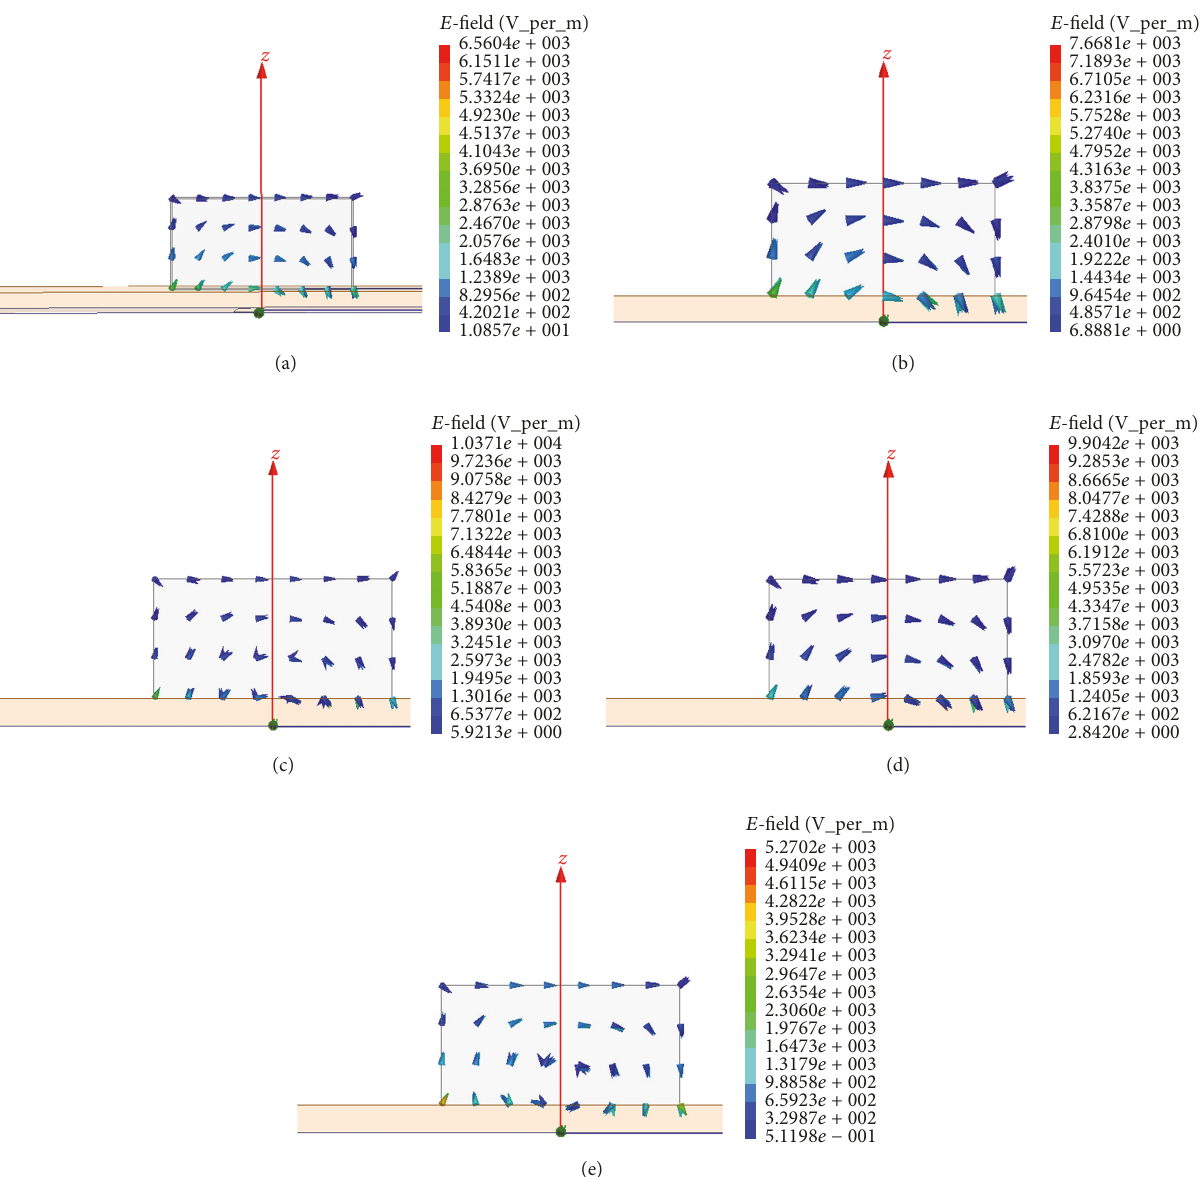
Figure 11: 𝐸 -field distributions on rectangular DRA. (a) Config-I, (b) Config-II, (c) Config-III, (d) Config-IV, and (e)